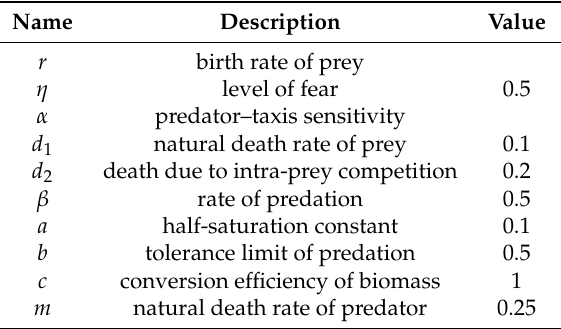
Table 1. Parameters of model (1) and their values in the numerical